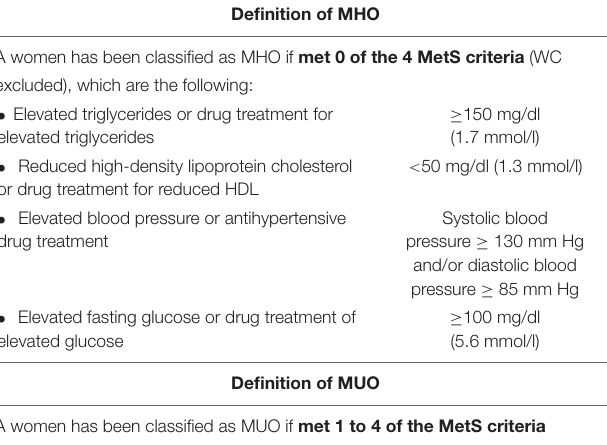
TABLE 1 | Diagnostic criteria for metabolic phenotypes of